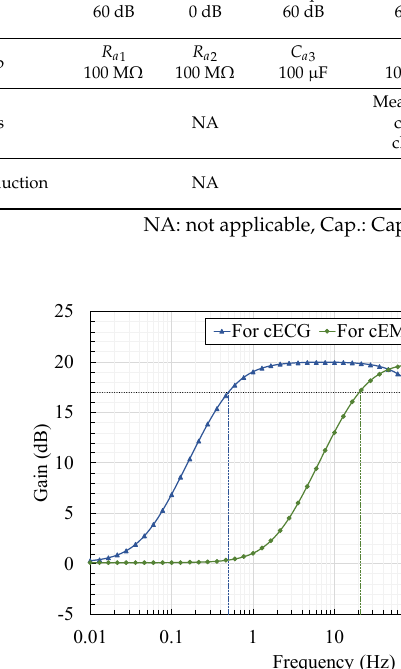
Figure 2. Frequency-gain characteristics of the proposed AFE with bandpass amplification tuned separately for cECG and cEMG measurements. Maximum gains were set to 20 dB for both measurements. Frequency passbands were set to 0.5–103 Hz for cECG and to 20–513 Hz for cEMG, respectively.